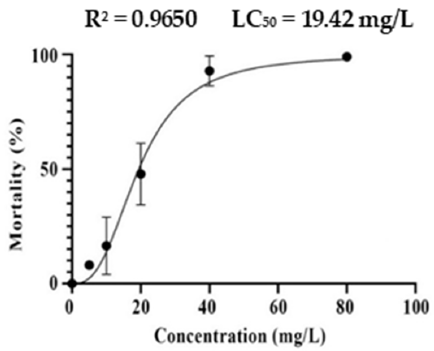
Figure 3. Zebrafish embryo mortality rates after exposure to 13p . As the time and concentration increased, zebrafish embryos showed obvious developmental delay (Figure 4), such as bent spine, pericardial cyst, yolk cyst and even malformation. At 72 hpf, compared to the control group, the zebrafish embryo exposed at 10 mg/L and 20 mg/L showed obvious yolk cyst. At 96 hpf, pericardial cyst and bent spine appeared on the zebrafish embryo exposed at 10 mg/L and 20 mg/L.